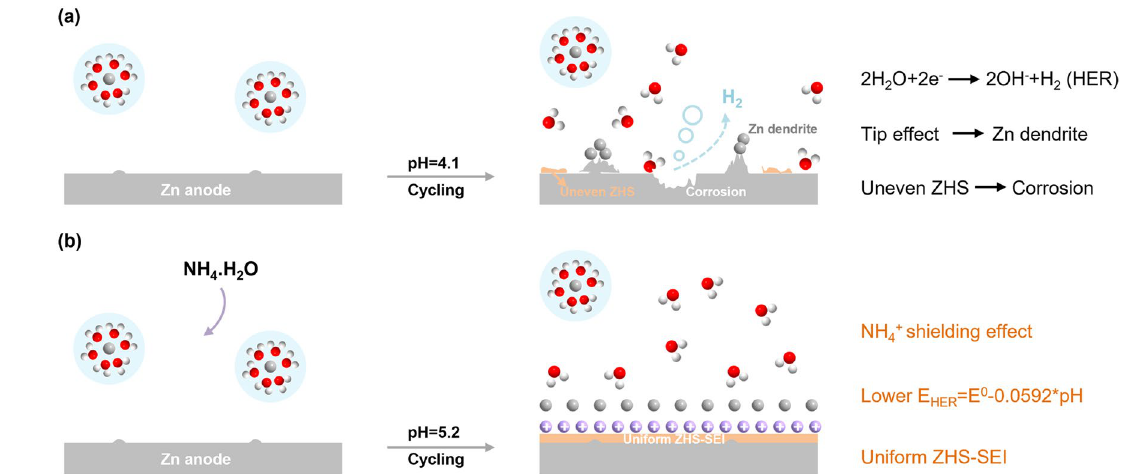
Fig. 1 Schematic illustration of the Zn plating process in a BE and b